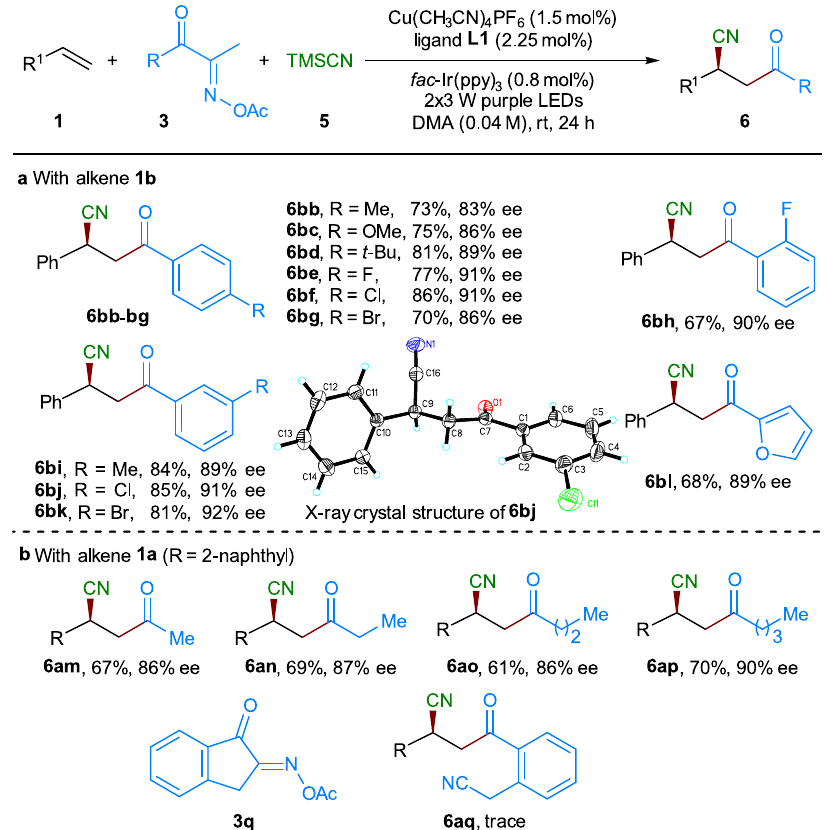
Fig. 4 Scope of the oxime esters in asymmetric three-component alkene acylcyanation. Reaction conditions: 1 (0.1 mmol), 3 (0.3 mmol), TMSCN (0.3 mmol), Cu(CH 3 CN) 4 PF 6 (1.5 mol%), ligand L1 (2.25 mol%), fac -Ir(ppy) 3 (0.8 mol%), DMA (2.5 mL), 2 × 3 W purple LEDs, at room temperature. Isolated yields were reported. The ee and d.r. values were determined by HPLC analysis on a chiral stationary phase. a With alkene 1b . b With alkene 1a